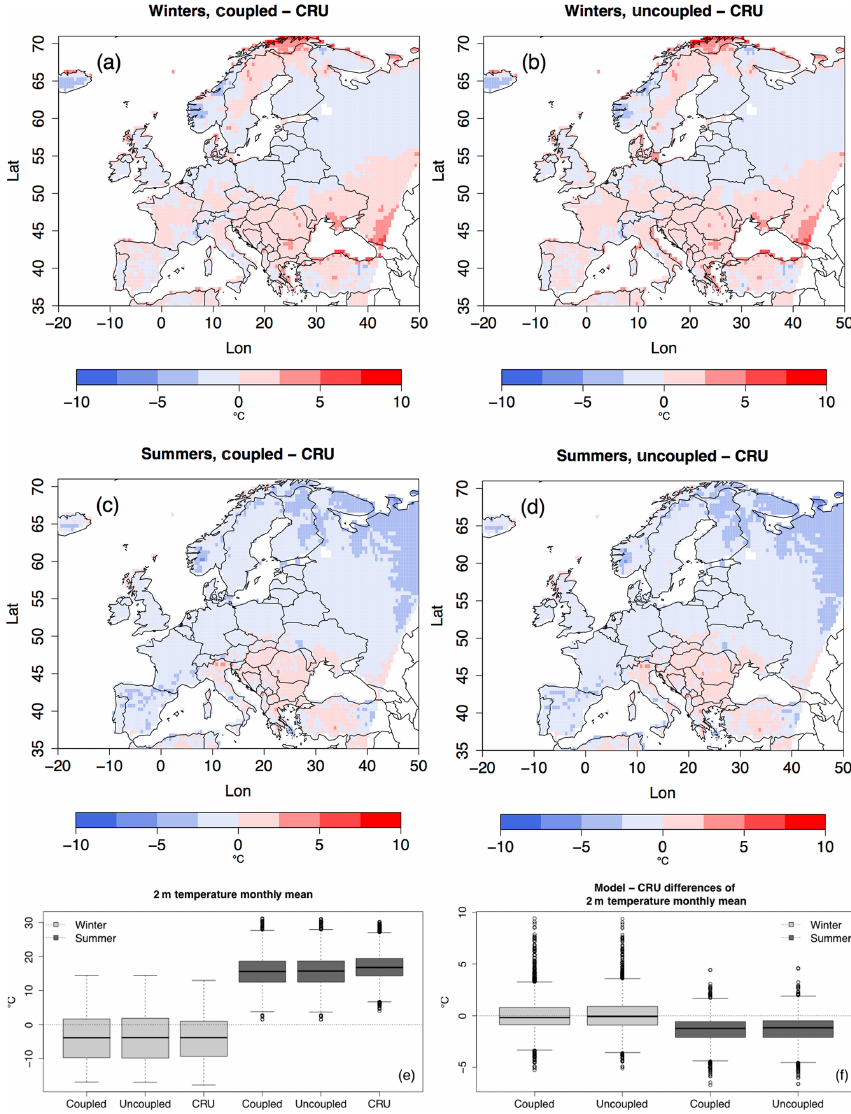
Figure 11. The 2m air temperature coupled system–CRU data differences (a, c) and the uncoupled system and CRU data (b, d) during winter (a, b) and summer (c, d) for the 20th century. Box plots of the 2m air temperature (e) and box plots of the regional model–CRU difference (f) . Box plots follow the same criterion as in previous